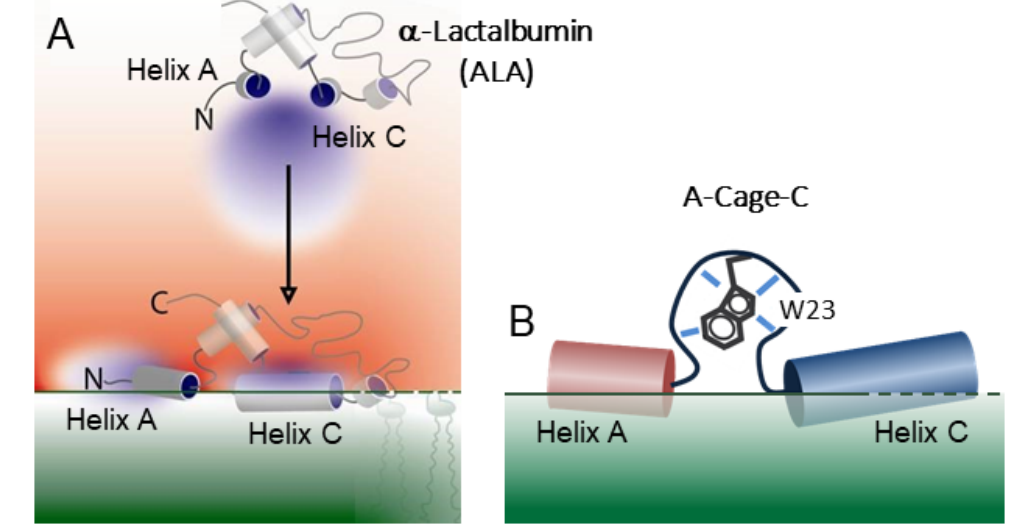
Figure 1. α -Lactalbumin and A-Cage-C. ( A ) Depiction of full-length ALA and the phospholipid membrane (green shading). The proton-gradient (red colour gradient) drives the interaction between the ALA and acidic membranes near the lipid bilayer at mildly acidic pH conditions (pH 4.5) by successive protonation at key residues in the A and C helix of the full-length protein [18]. Peptides derived from these helices can also form pore-like lesions when co-deposited as parts of lipid monolayers [33]. ( B ) Cartoon sketch of the A-Cage-C, derived from full-length ALA. Joining the two helices together with a short peptide to allow them to act together in the absence of the tertiary structure of ALA [34].